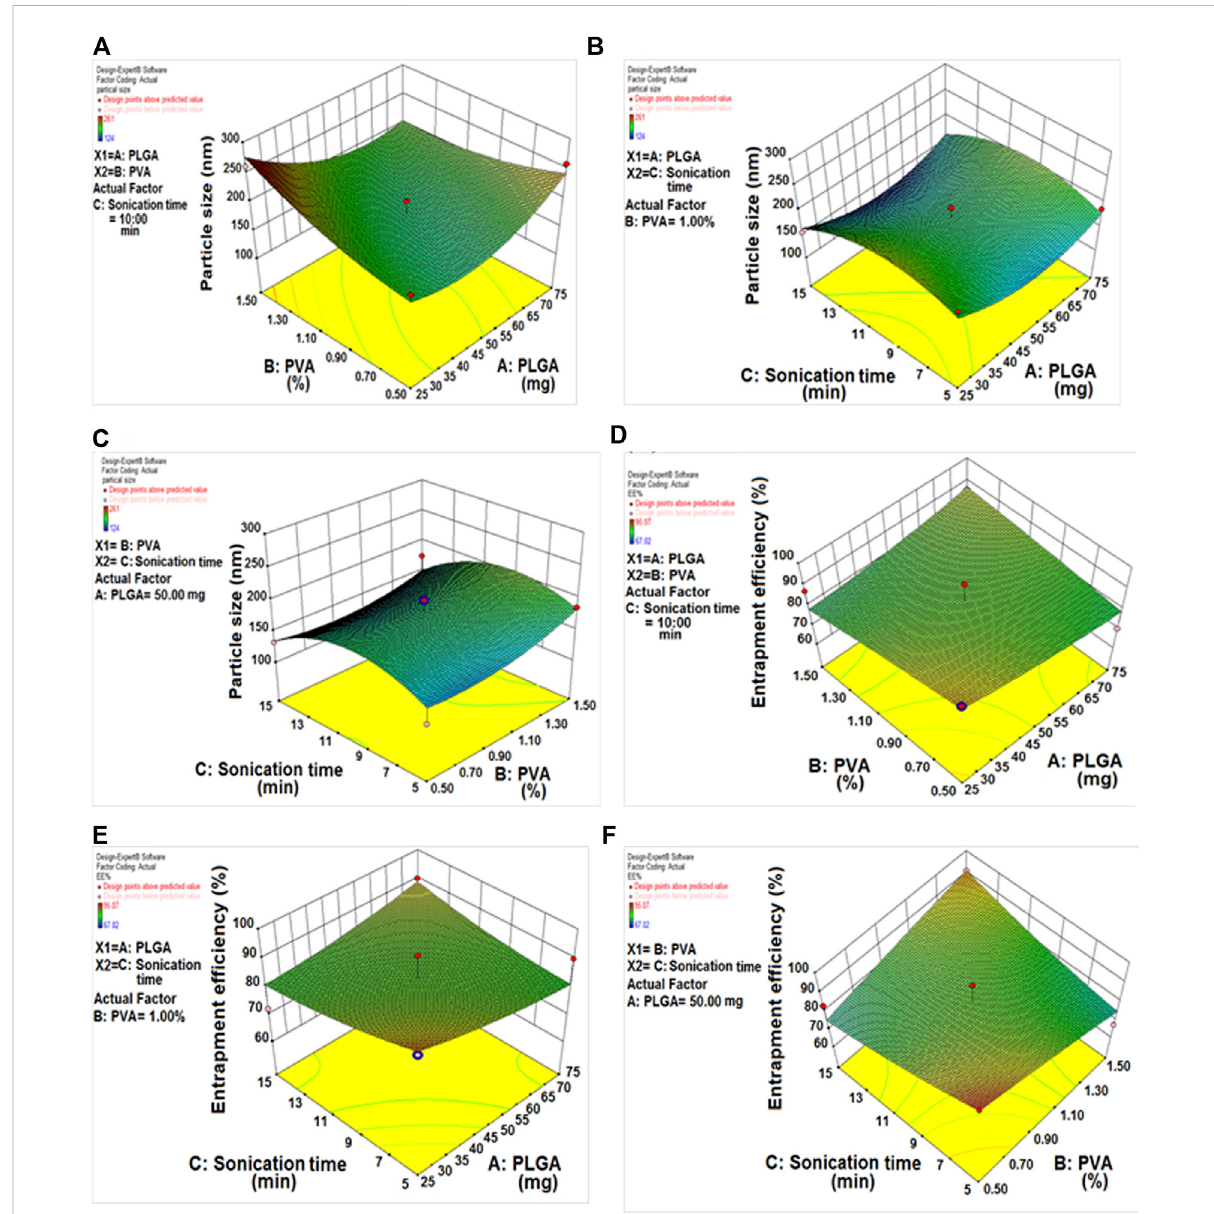
FIGURE 2 (A) Response3Dplot,effectofPLGA/PVAconcentrationonparticlesize. (B) Response3Dplot,effectofsonicationtime/PLGAconcentrationon particle size. (C) Response 3D plot, effect of sonication time/PVA concentration on particle size. (D) Response 3D plot, effect of PLGA/PVA concentrationonentrapmentef fi ciency. (E) Response3Dplot,effectofsonicationtime/PLGAconcentrationonentrapmentef fi ciency. (F) Response 3D plot, effect of sonication time/PVA concentration on entrapment ef fi